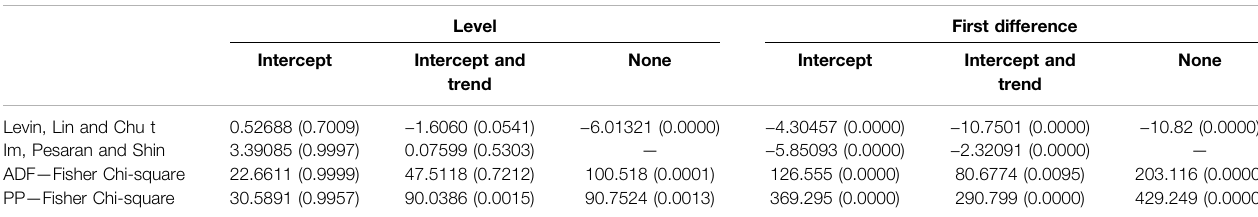
TABLE 2 | Unit root test of carbon emission variable (CO 2 ).